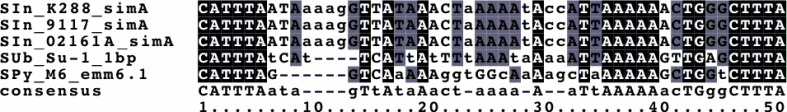
Comparison of putative Mga-like binding motifs upstream of sim genes.The 51 bp upstream regions of S. iniae sim genes with high similarity to GAS emm gene Mga binding sites are identical in strains K288, 9117, and 02161A. A 47 bp sequence sharing similarity to Mga-like binding sites located upstream of the gene encoding the S. uberis lactoferrin binding protein (Lbp, a close phylogenetic relative of SiMA) is also included for comparison. S. iniae and S. uberis putative binding motifs are aligned with the established 45 bp Mga binding site found in M6 GAS upstream of the emm6.1 M protein gene. Abbreviations: SIn–S. iniae, SUb–S. uberis, SPy–S. pyogenes.